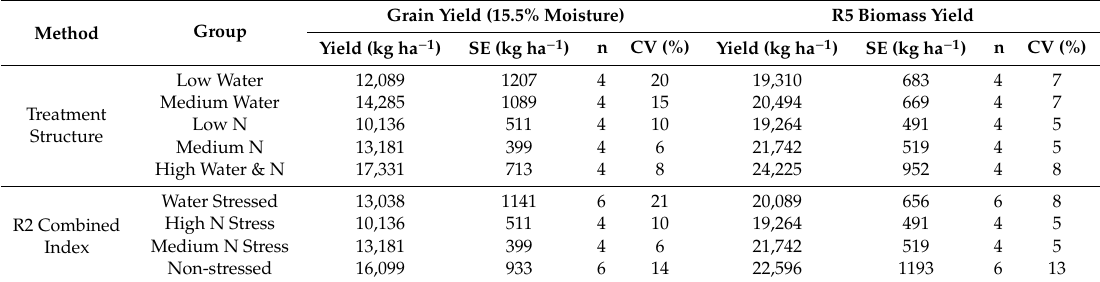
Table 5. A summary of the grain and dent (R5) biomass yields for the imposed water or nitrogen (N) treatments and Combined Index generated at blister (R2) at the experimental site. SE = standard error, CV = coe ffi cient of variation.